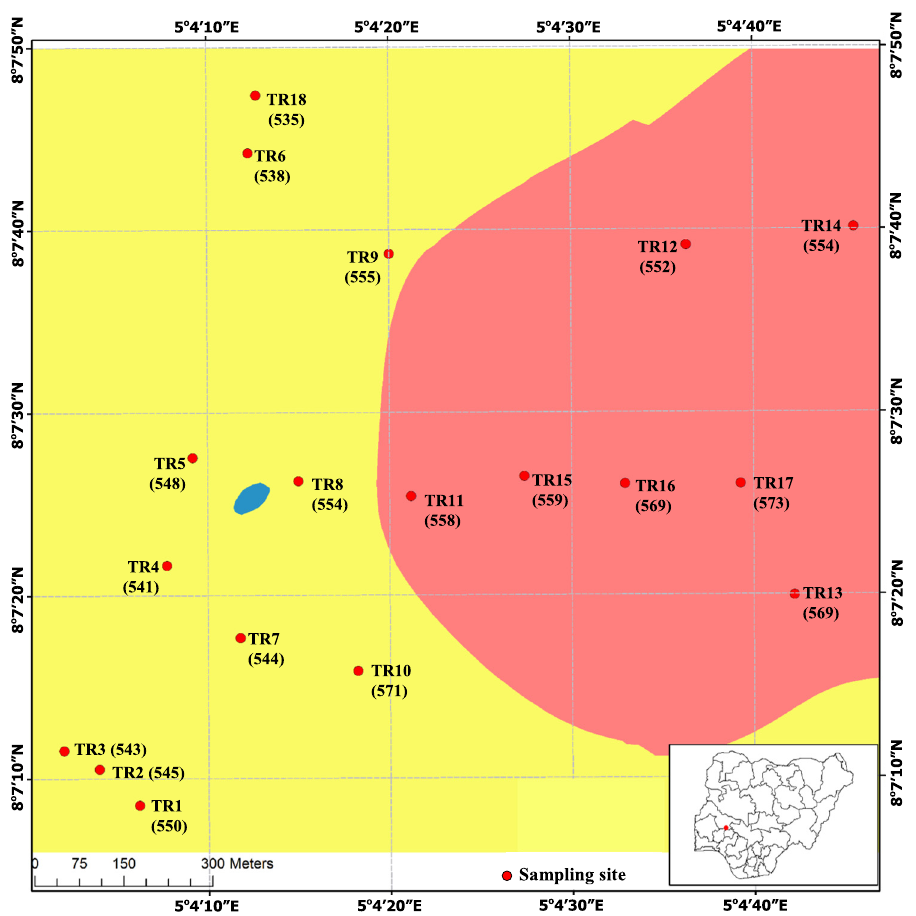
Figure 1: A map of the sample collection point with